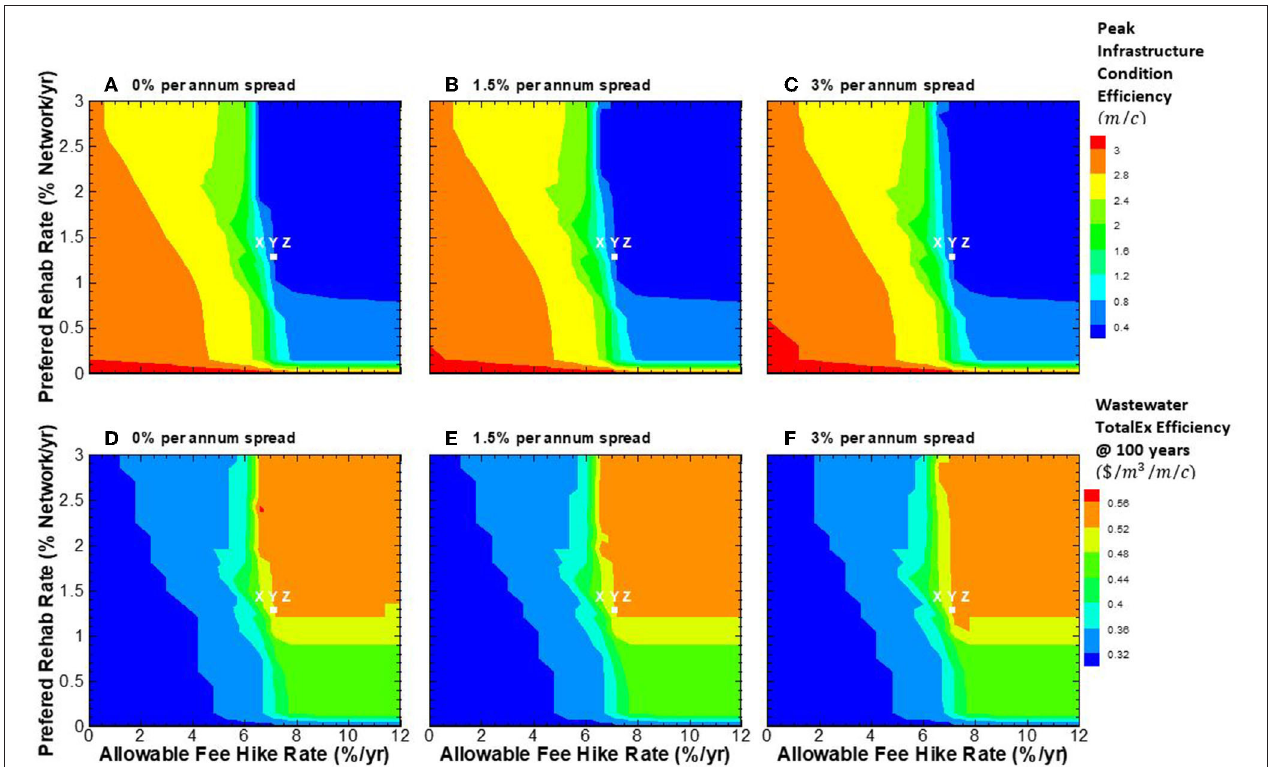
FIGURE 6 | (A–F) Impact of allowable fee hike and preferred rehabilitation rates on infrastructure condition efficiency and wastewater TotalEx